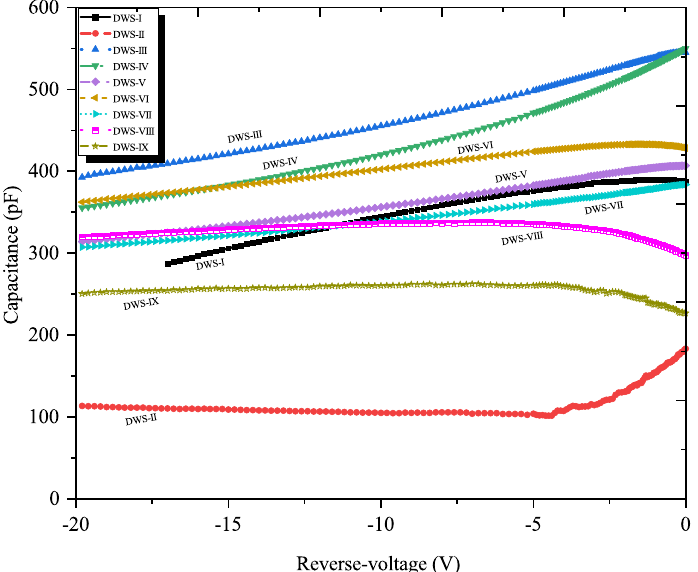
Figure 5. Room temperature C-V characteristics on various p -type 4H-SiC-SBDs (DWS# I-IX).